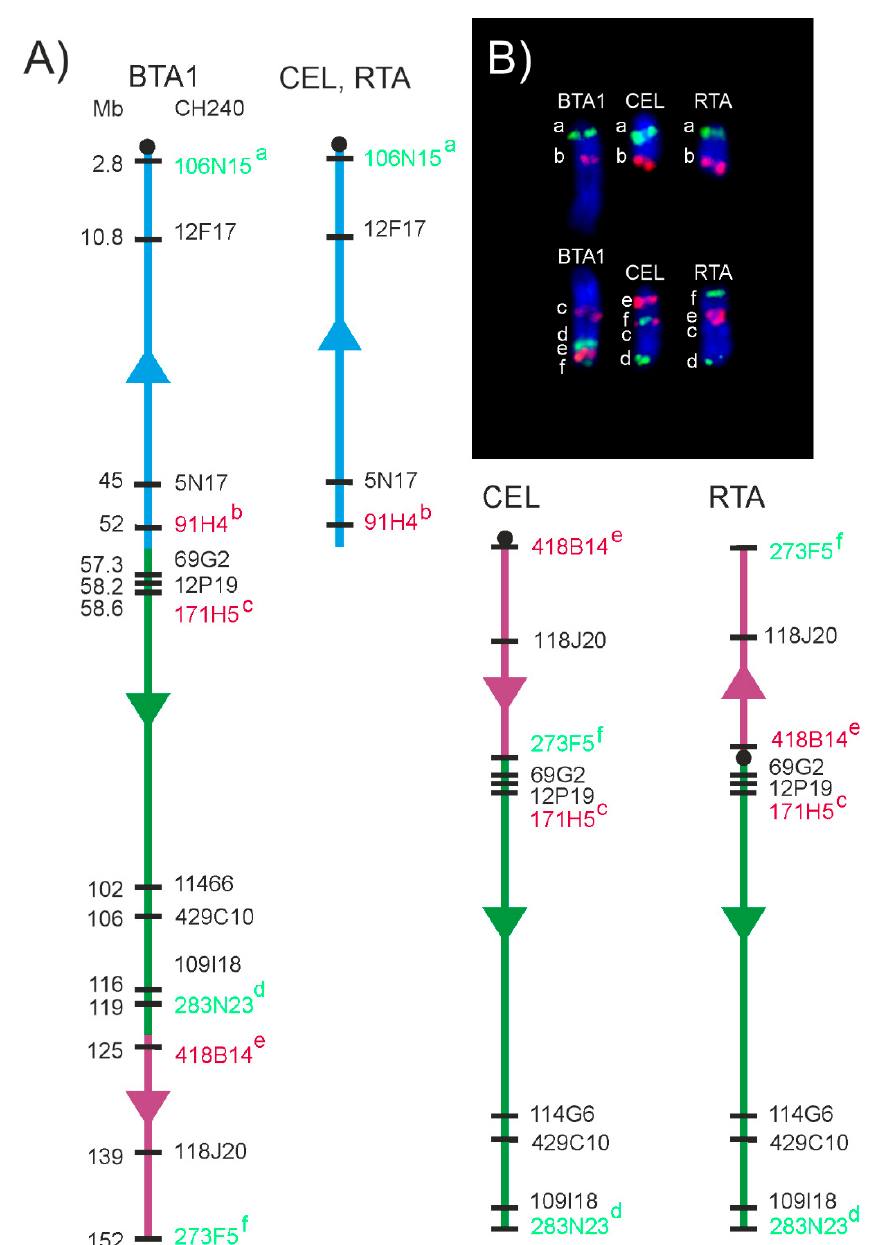
Figure 5. Evolutionary rearrangements of the BTA1 orthologue in Cervidae. ( A ) Schematic presentation. ( B ) BAC-FISH results in B. taurus (BTA), C. elaphus (CEL) and R. tarandus (RTA) using selected individual BAC probes indicated by letters (a–f): a—106N15, b—91H4, c—171H5, d—283N23, e—418B14, f—273F5.